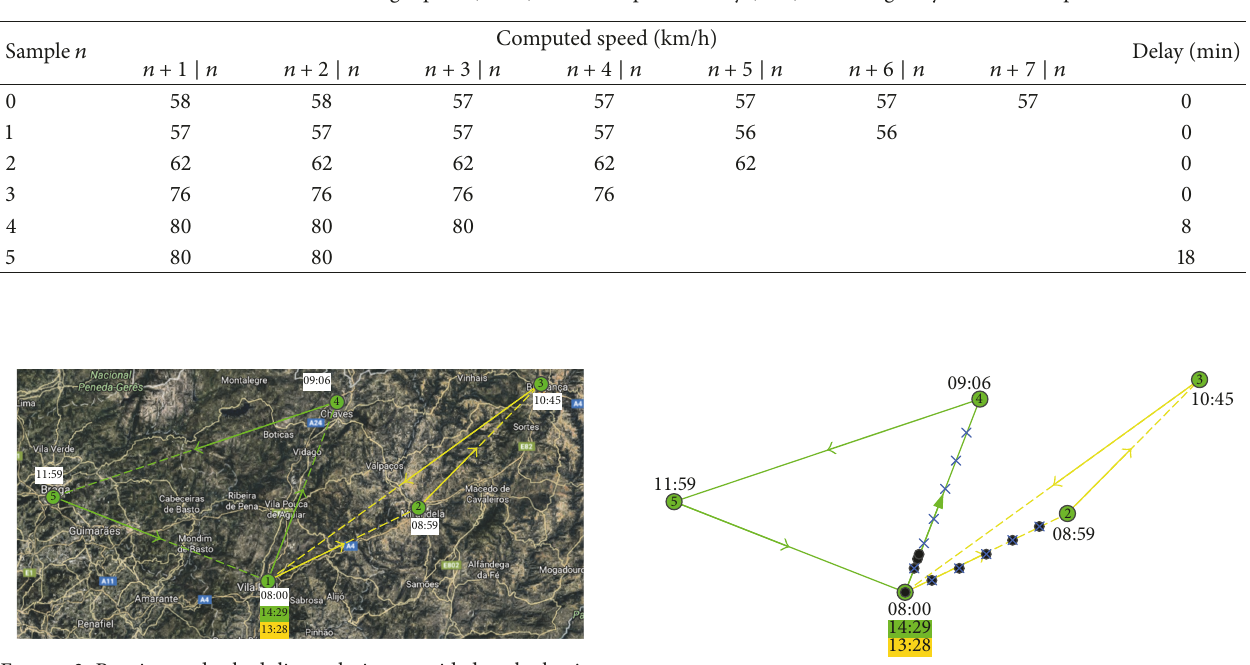
Figure 3: Routing and scheduling solution provided at the begin- ning of the day. Each coloured triangle represents a truck’s route. Figure 4: Trucks’ position evolution during the working schedule (the blue crosses indicate the trucks’ expected position and the black dots the trucks’ actual position).